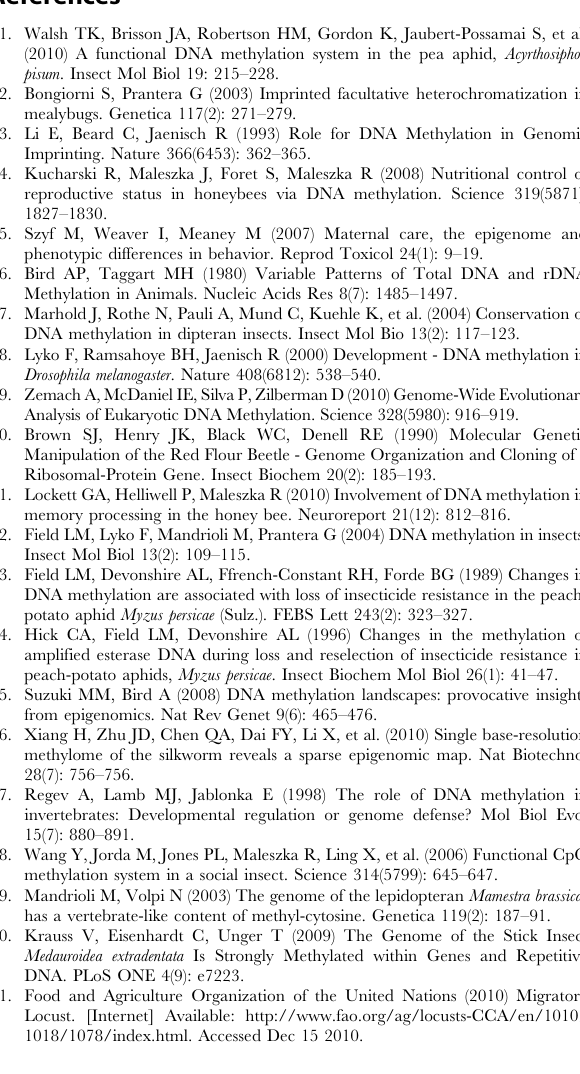
Figure S1 Observed to expected ratios for all dinucle- otide combinations. The number of genes is shown on the y- axis. For clarity O/E values greater than 3.00, where present,